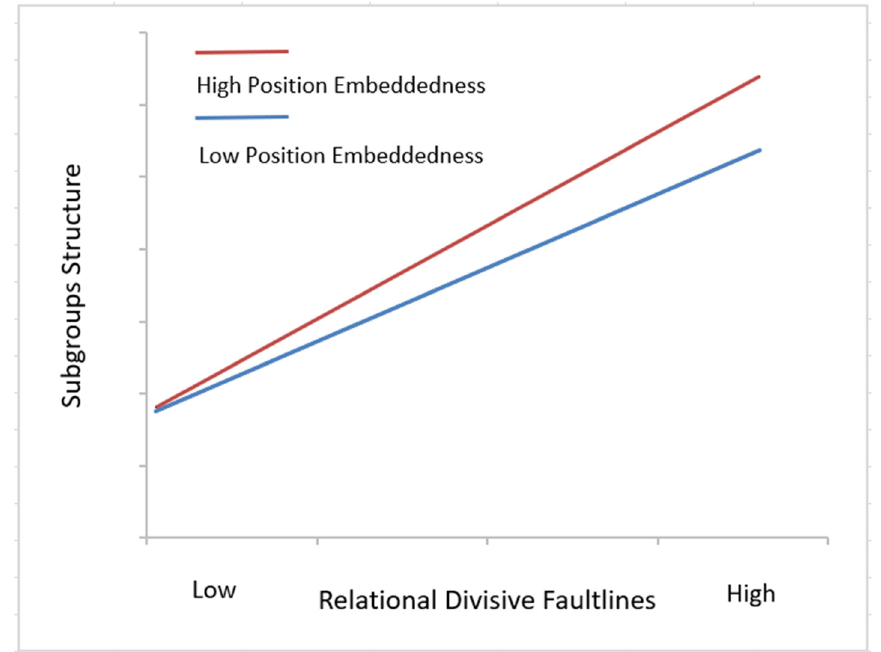
Figure 3. Interaction of Positional Embeddedness and Relational Divisive Faultlines on Subgroup Structure.